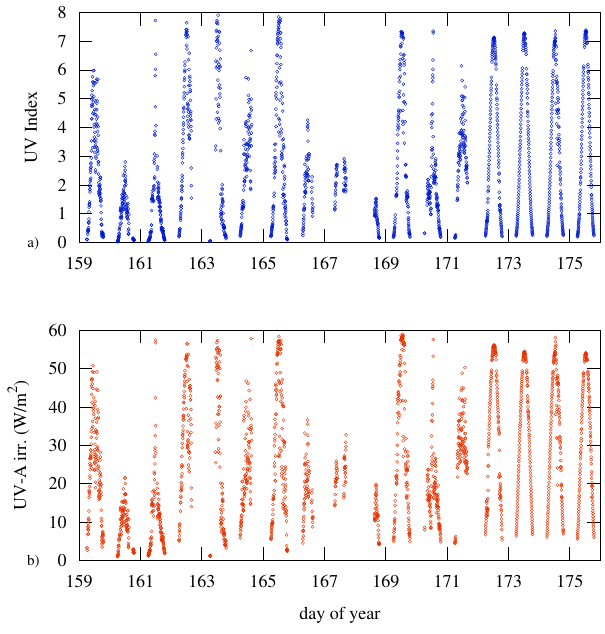
Fig. 3. Time series of Bentham measurements: (a) global solar UV Index and (b) UV-A irradiance. Data for rainy periods, before sunrise, after sunset, during calibration of the reference and dome cleaning were not included in the